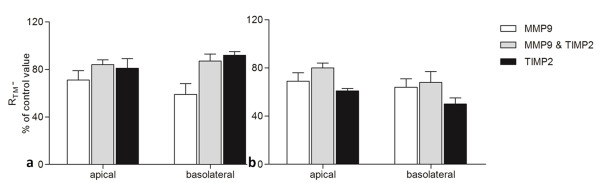
TIMP2 reverses partially the effect of MMP9 on pleural permeability. TIMP2 was added at concentration 200 ng/ml on the apical and basolateral side of parietal(a) and visceral pleura(b). MMP9 was added at the same time at concentration 0.1 ng/ml. TIMP2 seems to prevent partially the decline in RTM induced by MMP9 on the 40th minute of the experimental procedure. Data are given as mean ± SD. n = 6 for MMP9, n = 3 for combined MMP9 and TIMP2, n = 3 for TIMP2.